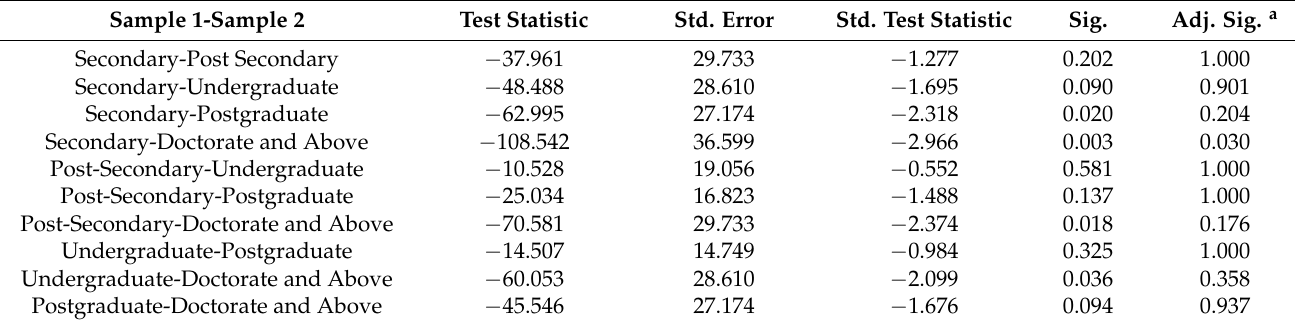
Table 13. Post hoc analysis—fluctuation in the value of